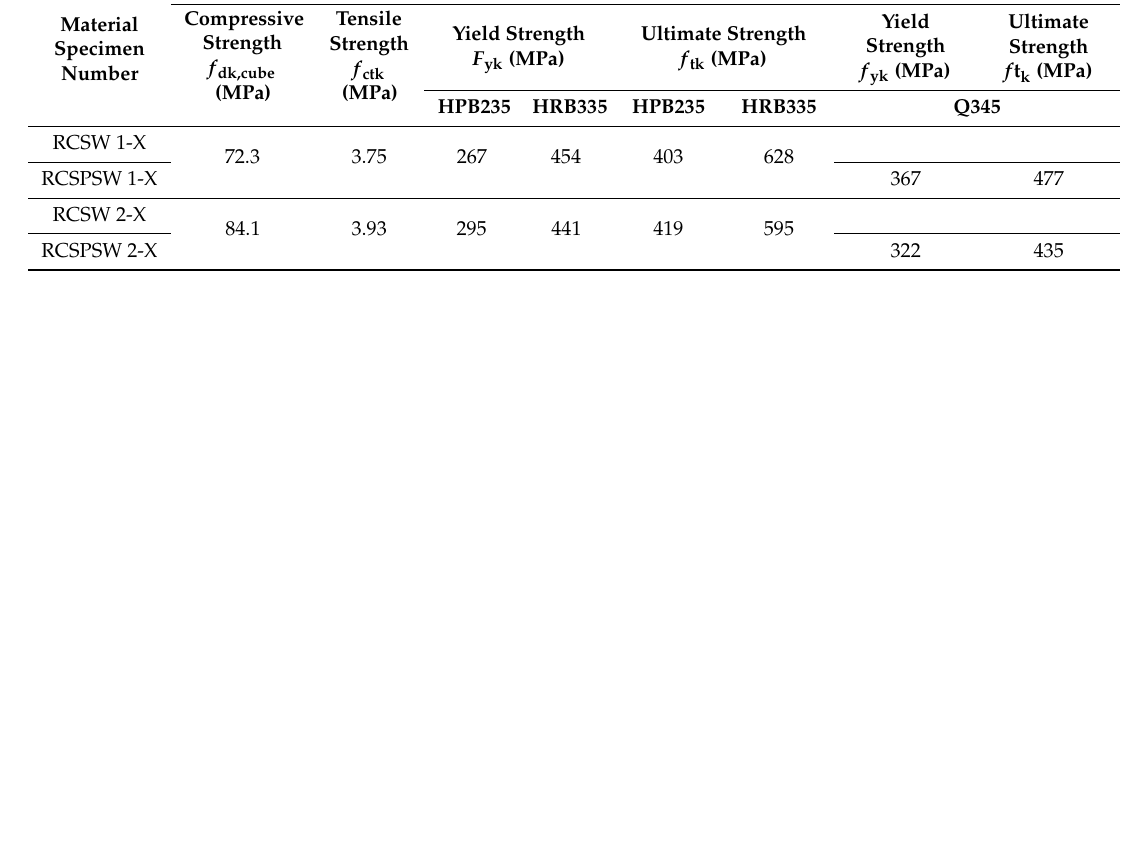
Table 2 lists key material properties of test specimens. The 28-day cubic compressive strength, f (cid:48) , for shear specimens and flexure specimens are 72.3 MPa and 84.1 MPa, respectively. Two types ck,cube of steel reinforcements (HPB235 and HRB 335) were used in the wall specimens. Table 2 summarizes